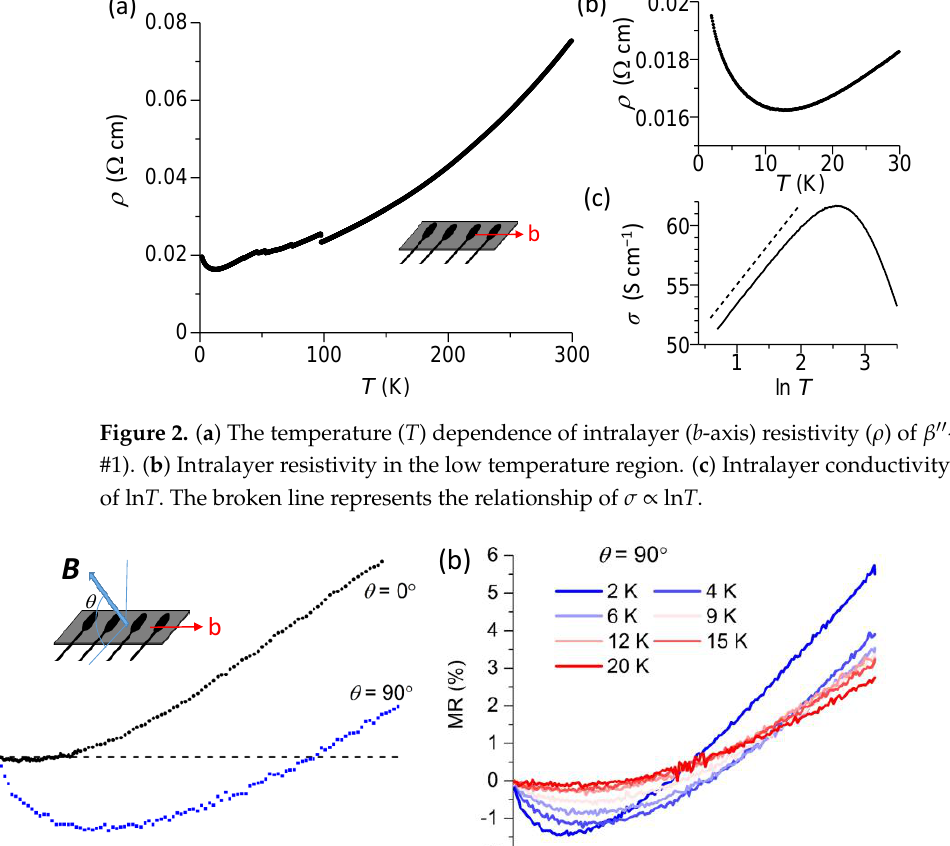
Figure 2. ( a ) The temperature ( T ) dependence of intralayer ( b -axis) resistivity ( ρ ) of β ” -BO3 (sample #1). ( b ) Intralayer resistivity in the low temperature region. ( c ) Intralayer conductivity as a function of ln T . The broken line represents the relationship of σ ∝ ln T .